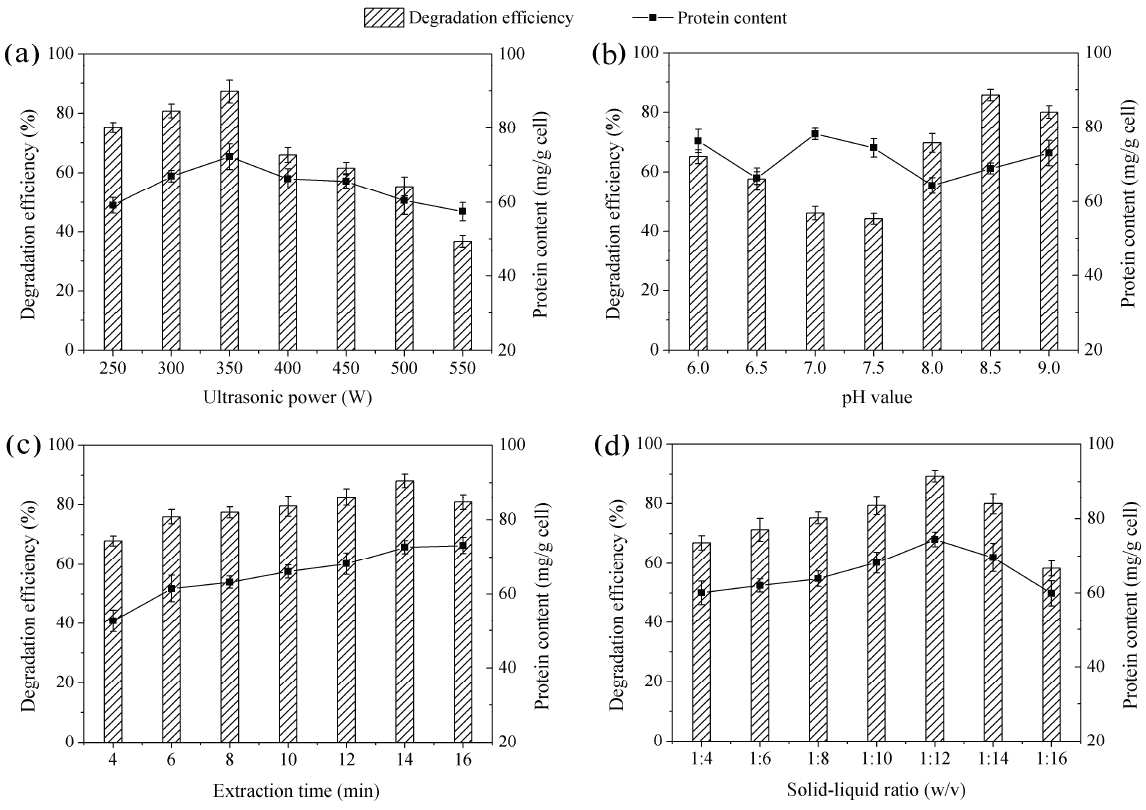
Figure 1. Degradation efficiency of BDE-209 and protein content of crude enzyme under different extraction conditions. ( a ) Ultrasonic power was set at 250–550 W, other conditions were set at pH 8.5, 14 min and 1:12; ( b ) pH value was set at 6.0–9.0, other conditions were set at 350 W, 14 min and 1:12; ( c ) Extraction time was set at 4–16 min, other conditions were set at 350 W, pH 8.5 and 1:12; ( d ) Solid-liquid ratio was set at 1:4–1:16, other conditions were set at 350 W, pH 8.5 and 14